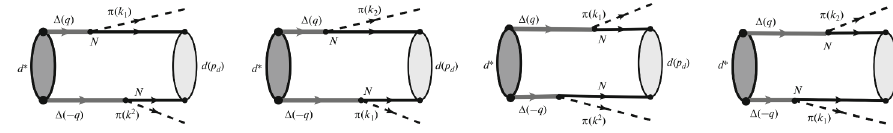
Figure 1. Illustration of d (cid:3) (2380) ! d (cid:25)(cid:25) decay.